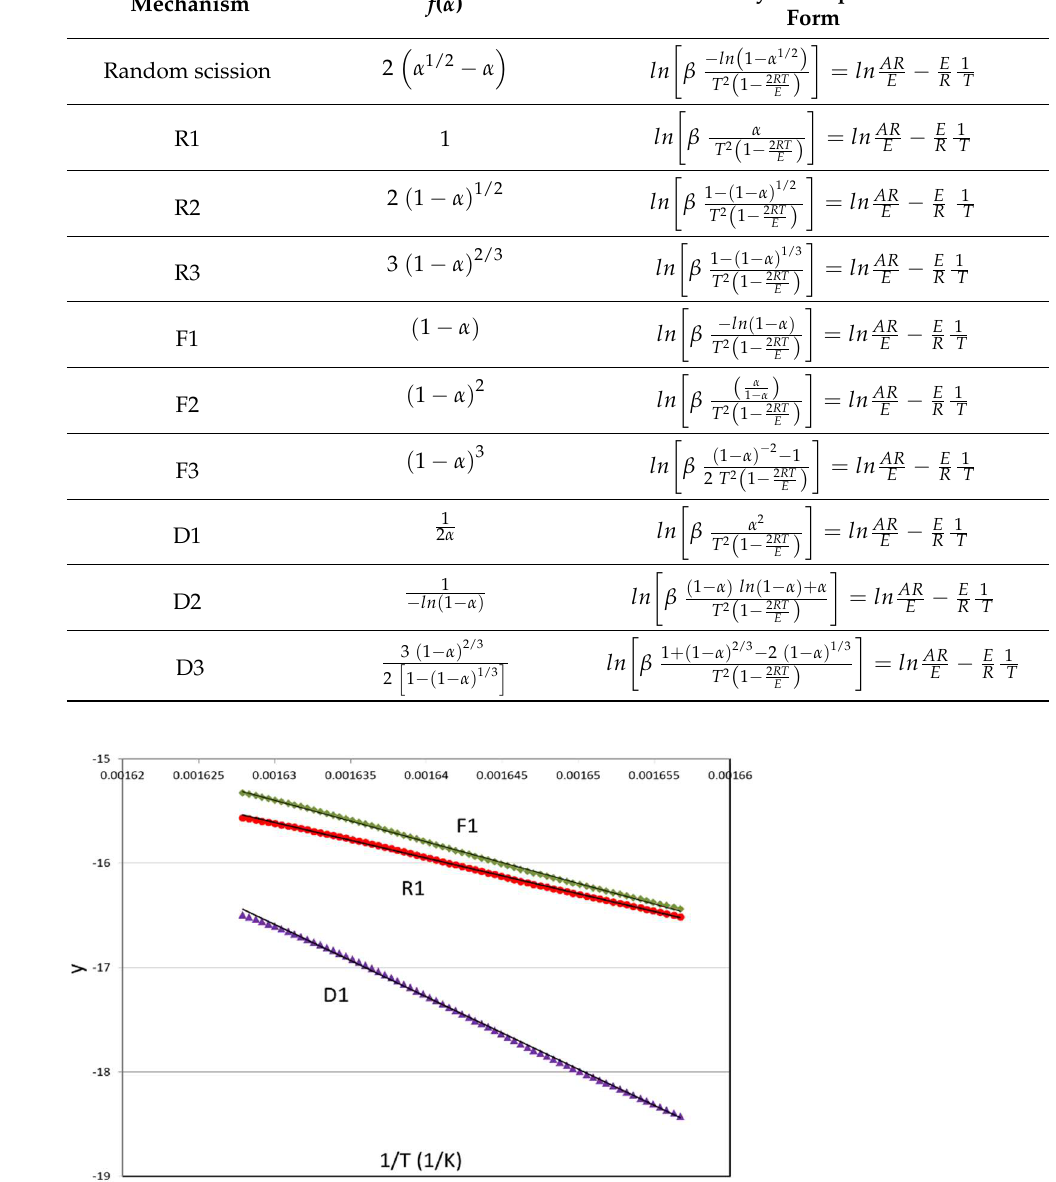
General Analytical Equation in Linear Form